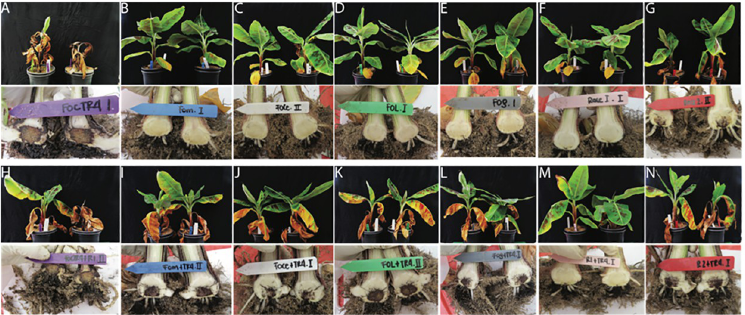
Fig 1. Disease development on Cavendish ‘Grand Naine’ with different Fusarium spp. (A-G): External and internal symptoms at six weeks after single inoculations with (A) Fusarium odoratissimum TR4, (B) F . oxysporum f. sp. melongenae , (C) F . oxysporum f. sp. cepae , (D) F . oxysporum f. sp. lycopersici , (E) F . oxysporum f. sp. gladioli , (F) F . oxysporum f. sp. cubense R1, and (G) F . tardichlamydosporum R2. (H-N): External and internal symptoms at six weeks after primed inoculations as follows (H) First inoculation with TR4 followed by challenging with R1 and (I-N) first inoculation as per (B-G) followed by a challenge with TR4.